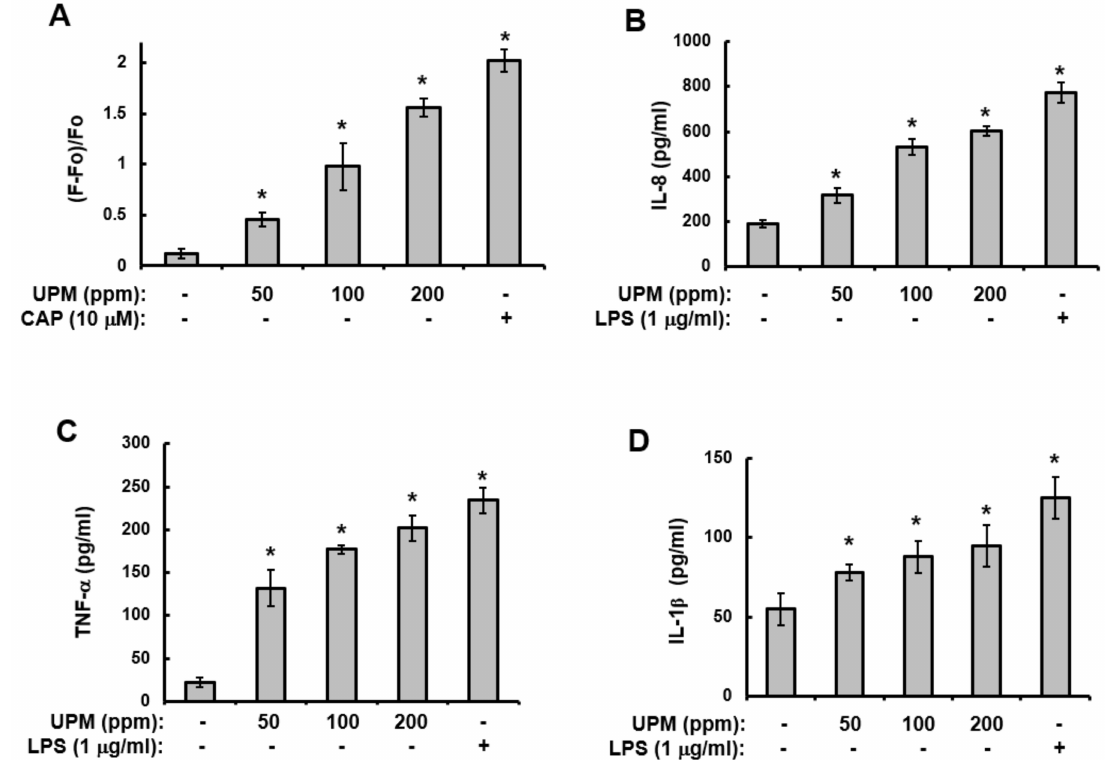
Figure 4. UPM increases Ca 2+ influx and the production of pro-inflammatory cytokines. ( A ) HaCaT cells were loaded with Fura2-AM for 60 min and then washed with Krebs-HEPES buffer for the [Ca 2+ ] i measurement. The [Ca 2+ ] i was measured fluorometrically every 5 s for 100 sec after the addition of 200 ppm UPM, as described in the Materials and Methods (Section 4). The curve shown is representative of three independent experiments. ( B – D ) HaCaT cells were treated with the indicated concentrations of UPM for two days. The supernatants were then analyzed using the Multi-Target Sandwich ELISA Kits for interleukin-8 (IL-8) ( B ), TNF- α ( C ), and IL-1 β ( D ). The results were verified using three independent experiments, each of which was conducted in duplicate. * p < 0.05 vs. control. The data are expressed as the mean ± S.D. UPM, urban particulate matter; LPS, lipopolysaccharide; CAP,